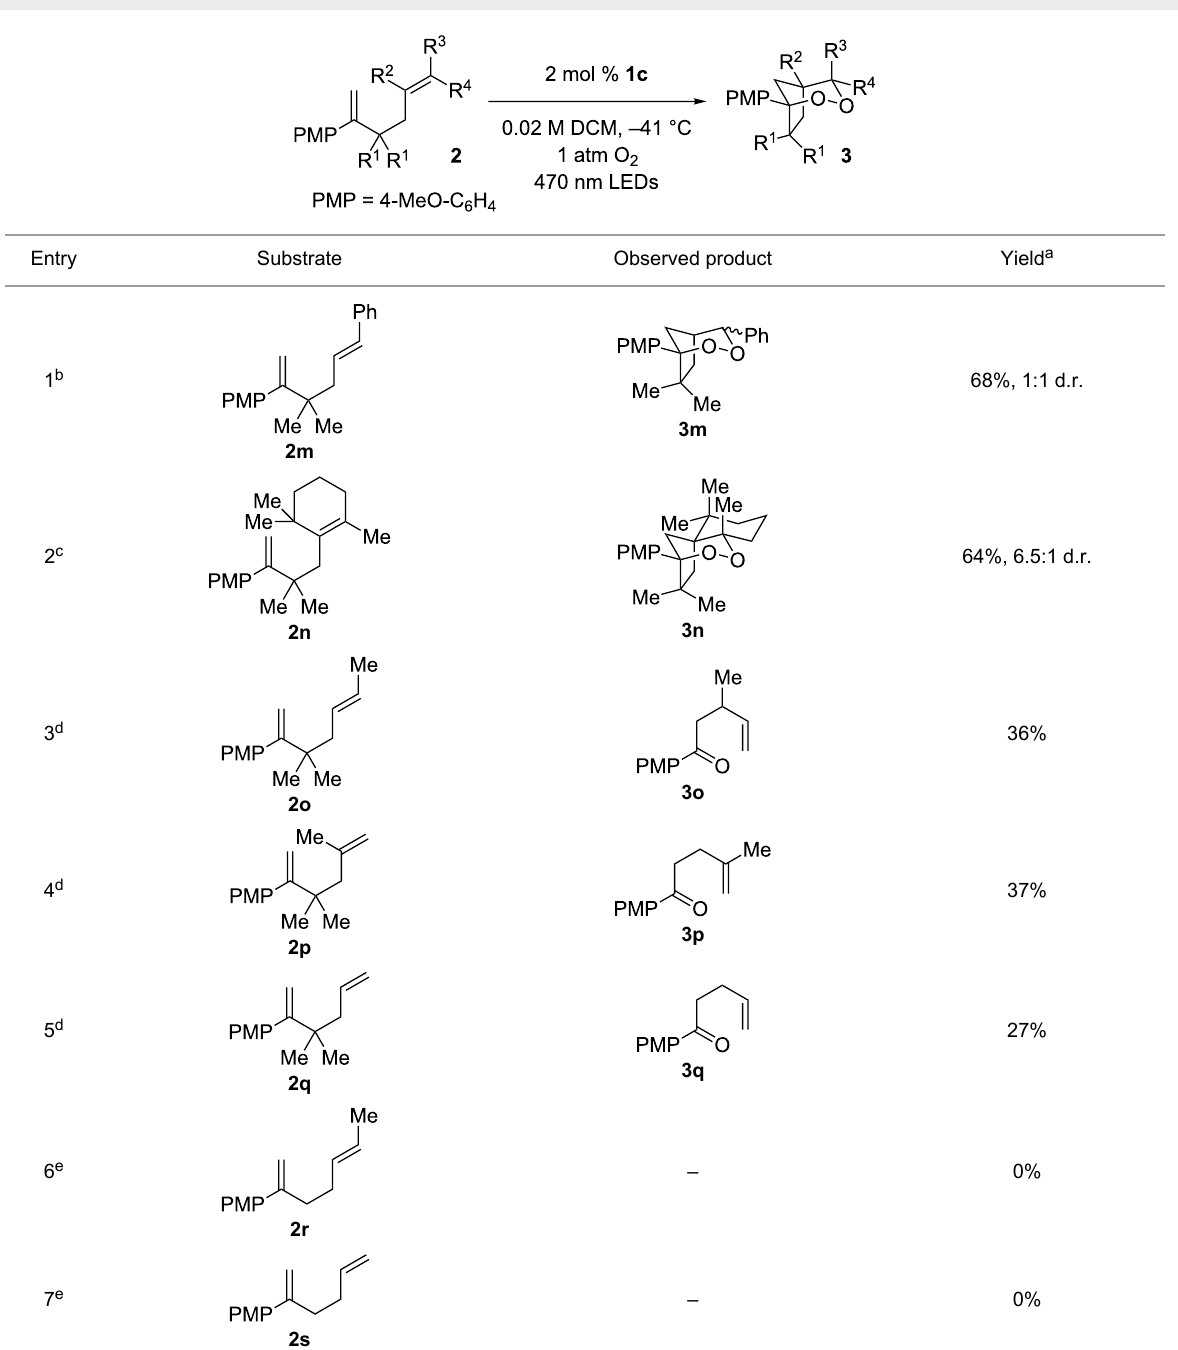
Table 3: Variation of the tethered alkene